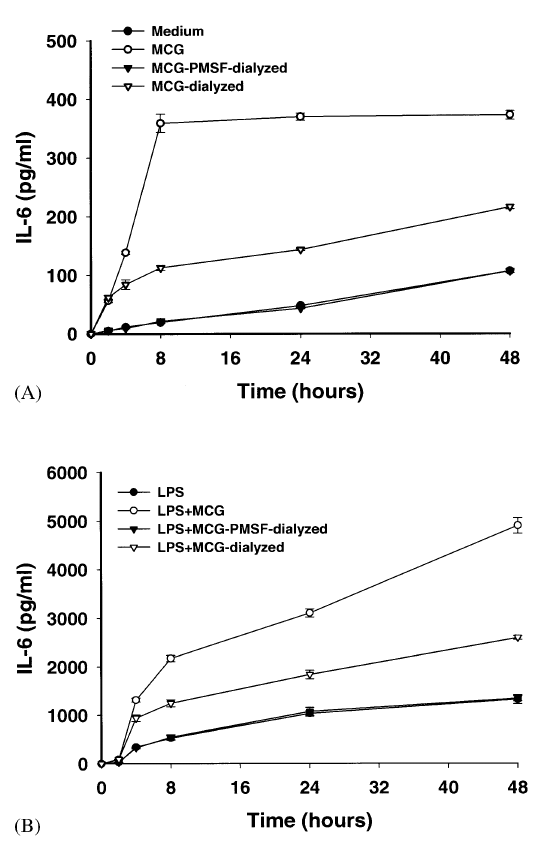
FIG. 1. Kinetics of IL-6 production by LPS-activated and MCG- activated HUVECs. HUVEC monolayers (10,000) were cul- tured with PMSF-treated and dialyzed MCG, dialyzed MCG or intact MCG (5000 mast cell equivalents) in the absence (A) and presence (B) of 100 ng/ml of LPS for the time intervals indicated. IL-6 concentrations in the culture media were assayed by ELISA. Values are the mean 9 / standard error of the mean of quadruplicate culture